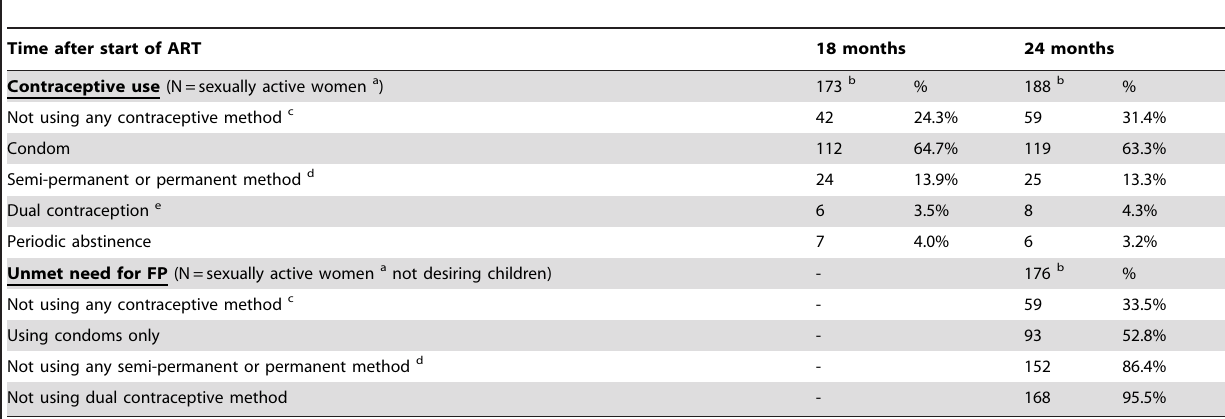
Table 2. Contraceptive use and unmet need for family planning among sexually active women on ART.